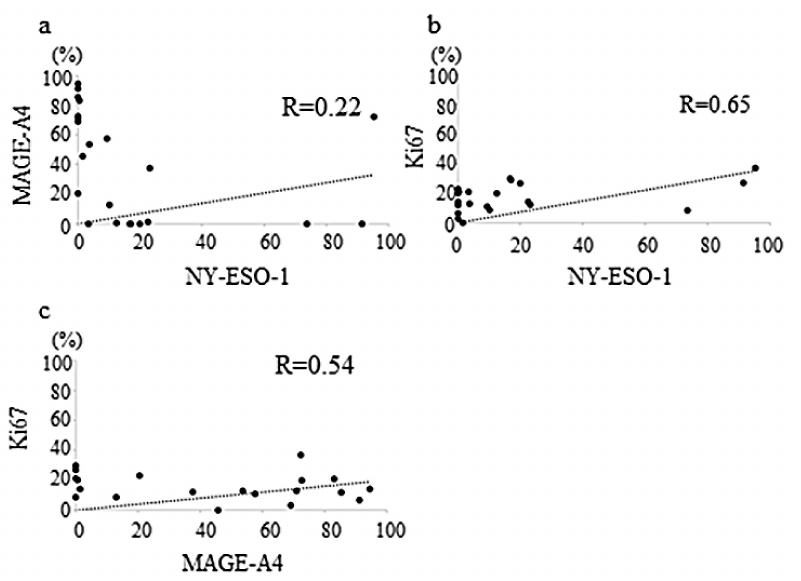
Figure 2. Graphs showing no positive correlation between the NY-ESO-1 and MAGE-A4 expression levels (r = 0.22) in sarcomas ( a ); weak positive correlation between the NY-ESO-1 and Ki67 expression levels (r = 0.65) in sarcomas ( b ); and weak positive correlation between the MAGE-A4 and Ki67 expression levels (r = 0.54) in sarcomas ( c ).